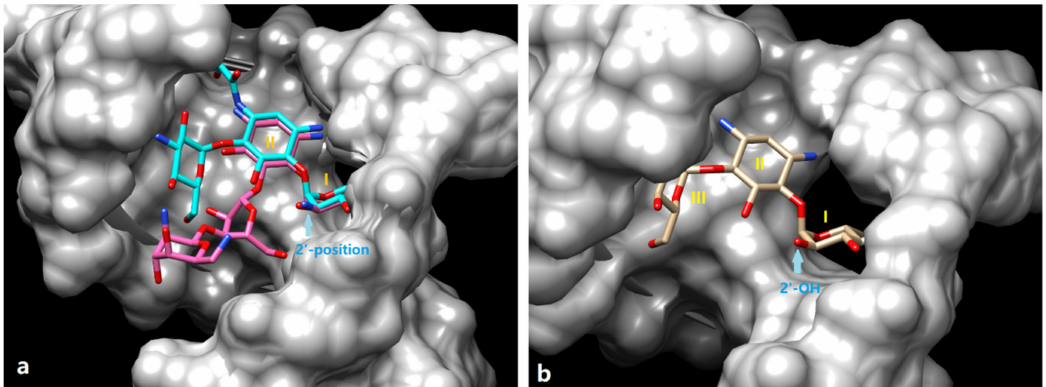
Figure 3. Crystal structures of neamine-containing aminoglycosides binding to A site. ( a ) The complexes of amikacin (cyanic, PDB ID: 4P20) and neomycin B (pink, PDB ID: 2ET4) with the decoding site are superimposed (based on nucleic acid chains). The neamine moiety is marked with Roman numerals I and II. The nucleic acid chains are colored in grey; ( b ) the complex of kanamycin A binding to A site (PDB ID: 2ESI). In both figures, 2 (cid:48) -position is